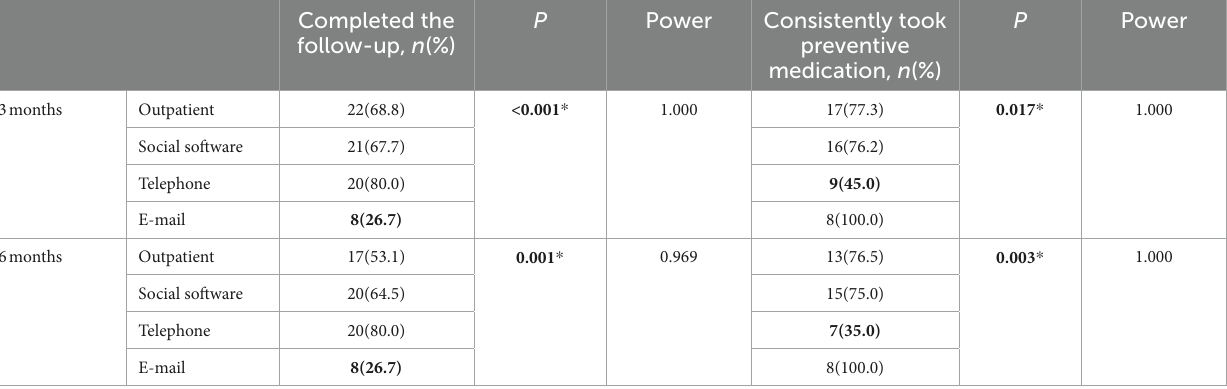
TABLE 4 Compliance at 3 and 6 months in each group.